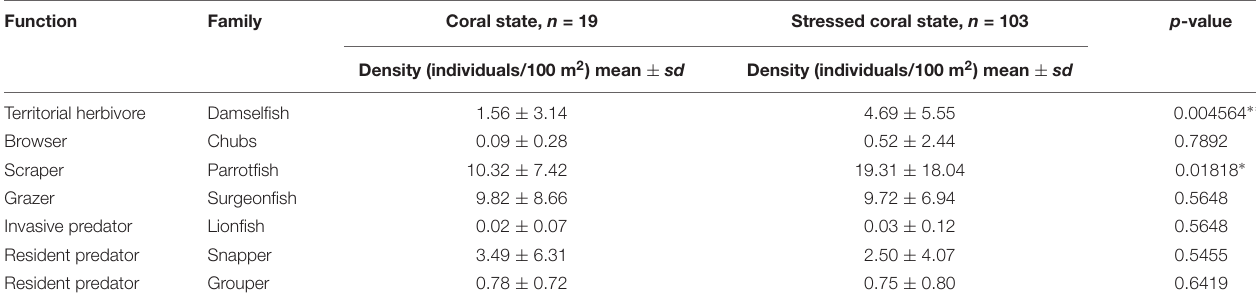
TABLE 3 | Mean and standard deviation ( sd ) of key fish density in each coral state, present at an n number of sites for both years combined.